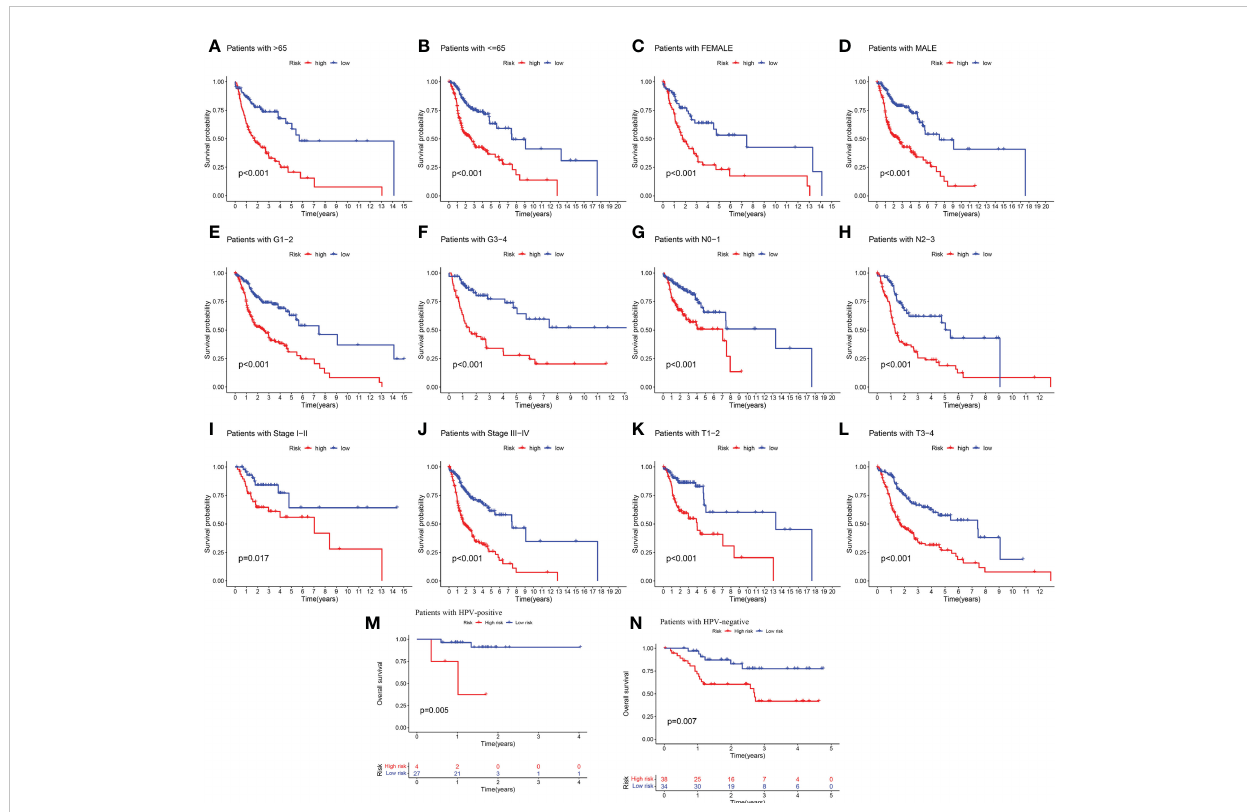
FIGURE 5 Clinical correlation and survival analysis of 6-CRRGs in patients with HNSCC (A, B) age, (C, D) gender, (E, F) tumor grade, (G, H) N stage, (I, J) tumor stage, (K, L) T stage, and (M, N) HPV